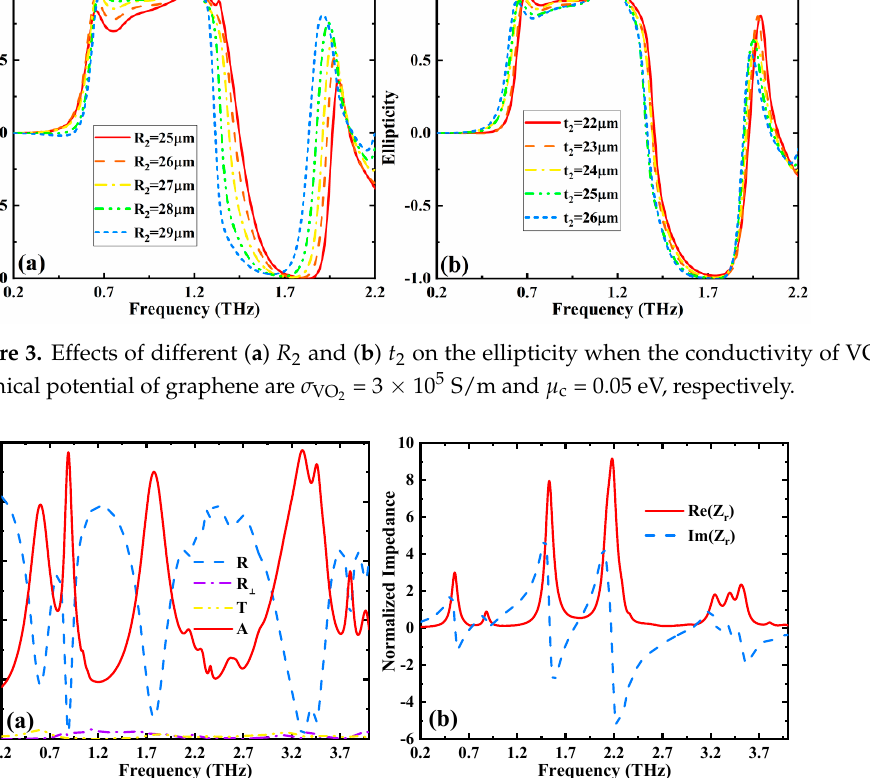
Figure 4. ( a ) Reflectance spectrum, transmittance spectrum, and absorption spectrum of the metamaterial structure; ( b ) real and imaginary part of the relative impedance, with σ VO and µ c = 1.2 eV.